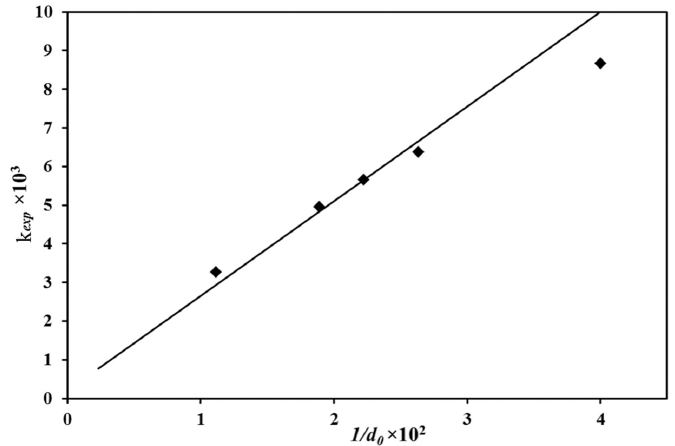
Figure 10. Dependence of k exp on particle size, k exp α 1/ d 0 . The order of reaction obtained with respect to the NaOH concentration was n = 0.94. for [OH − ] ≥ 3.00 × 10 − 3 mol/L (Figure 11a). The reaction rate had a strong dependence on